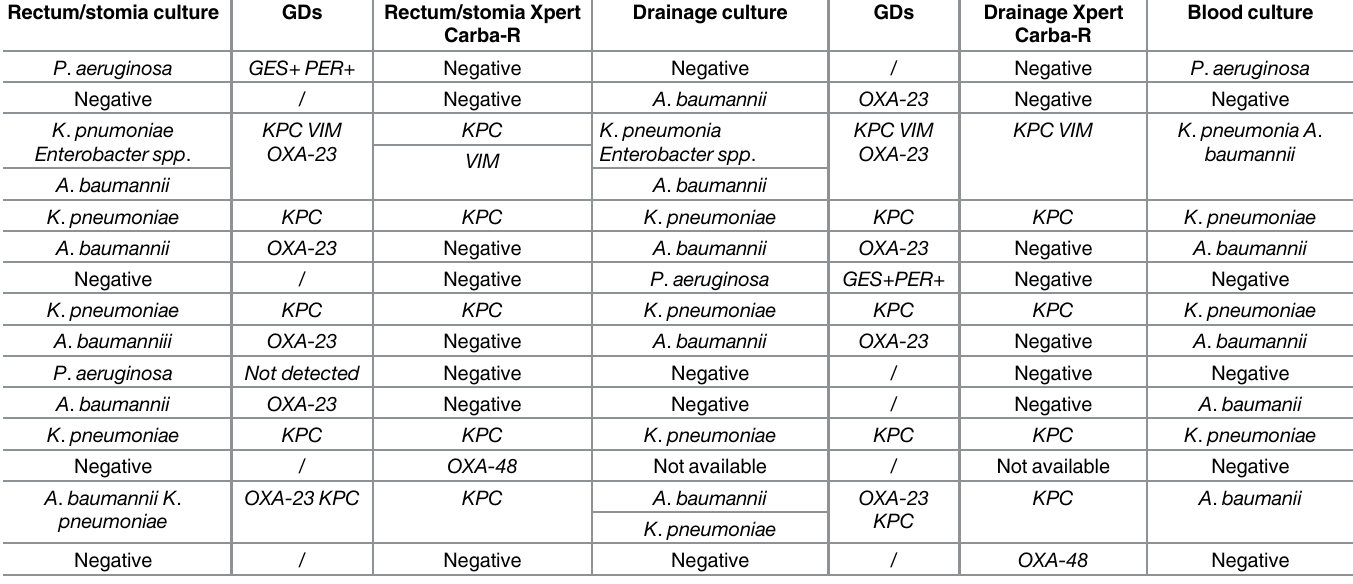
Table 2. Descripition of positive specimens from at least one site by either microbiological cultures or Xpert Carba-R. Genetic determinants (GDs) of carbapenem resistance were detected by in-house PCR. Rectum/stomia culture